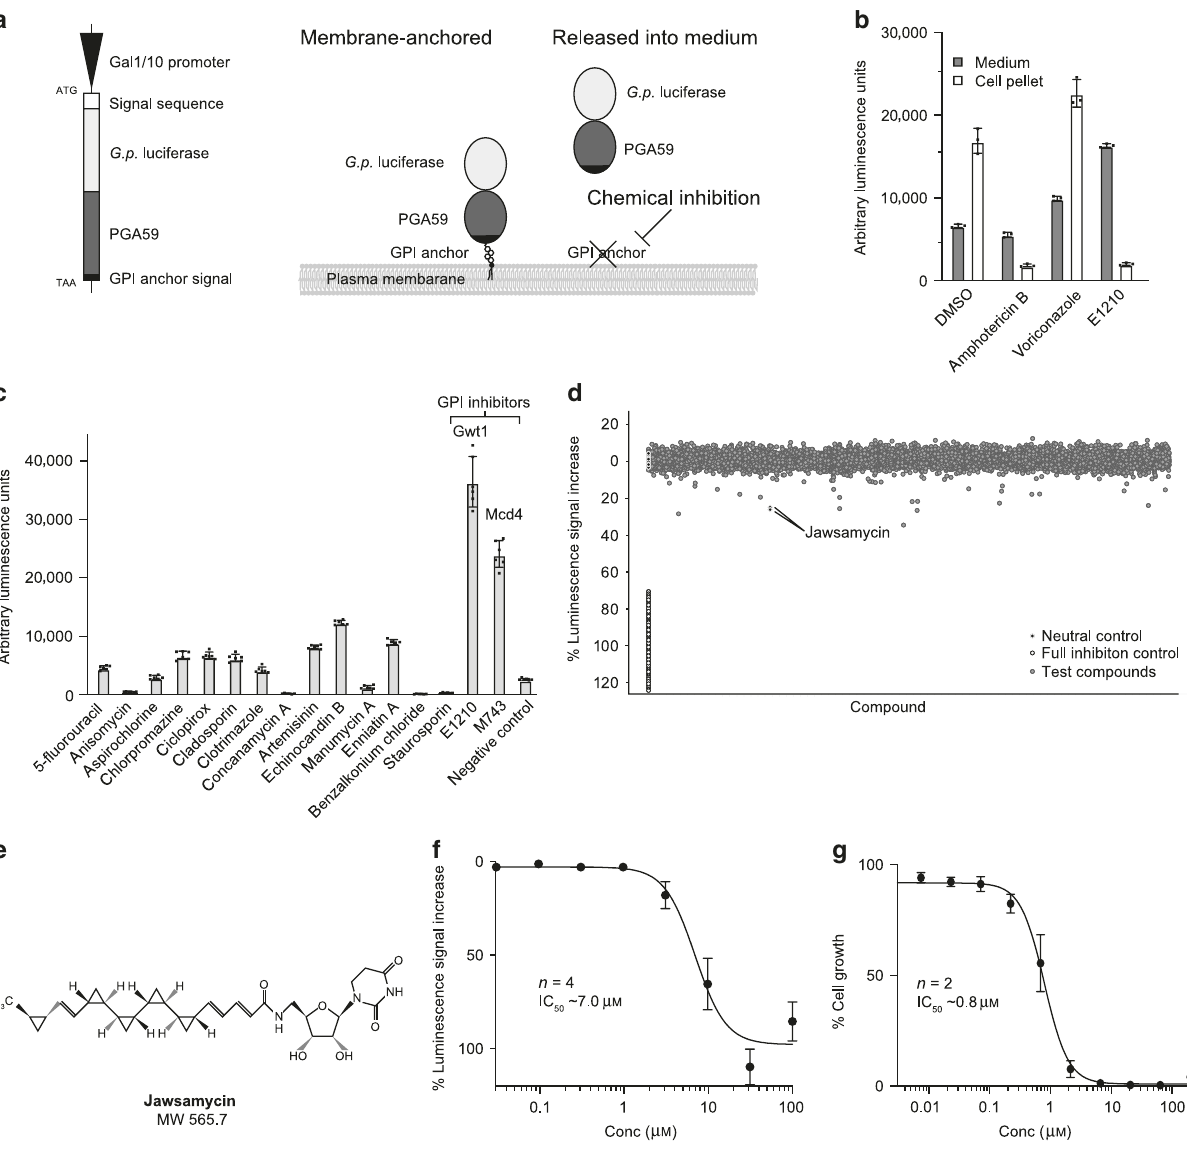
Fig. 1 Identi fi cation of jawsamycin in a screen for GPI biosynthesis inhibitors. a Schematic representation of reporter gene construct and assay principle. b Characterization of signal distribution in medium and pellet upon growth inhibition. Approximate IC 50 compound concentrations determined in pre- experiments were used in the test (1 μ M for voriconazole and E1210, 10 μ M amphotericin B). c Testing of assay speci fi city using inhibitors against different known targets and pathways. d Primary assay data of 12472 natural products screened at 10 μ M. e Structure of jawsamycin, a key hit in the screen. f Dose- response validation of jawsamycin in the reporter gene assay. g Dose-response validation of jawsamycin against growth of S. cerevisiae . Bars in panel b depict the mean of 3, in panel c the mean of 6 measured wells, dots in panel f and g depict the mean of 2 replicates; in all panels error bars depict + / − one standard deviation. All raw data is available in the Source Data fi